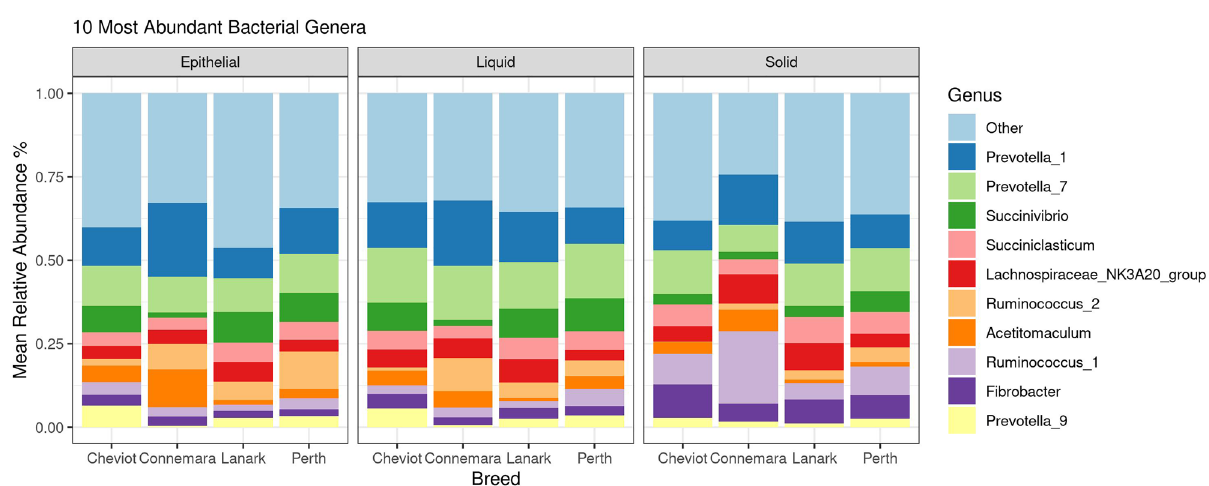
Figure 2. Stack barchart representing the mean relative abundance of the 10 most dominant genera across breeds (i.e. Cheviot, Connemara, Lanark, Perth) for solid liquid and epithelial ruminal fractions. Solid (Cheviot n = 8, Connemara n = 5, Lanark n = 9, Perth n = 7), liquid (Cheviot n = 9, Connemara n = 5, Lanark n = 9, Perth n = 5), epithelial (Cheviot n = 9, Connemara n = 3, Lanark n = 6, Perth n =